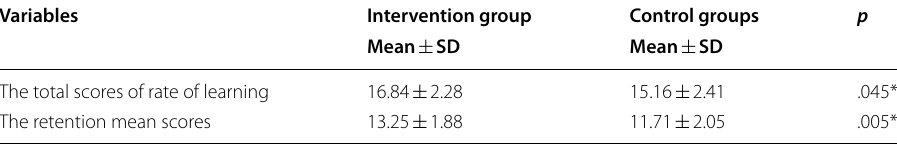
Table 2 Comparison of learning rate scores in intervention and control groups